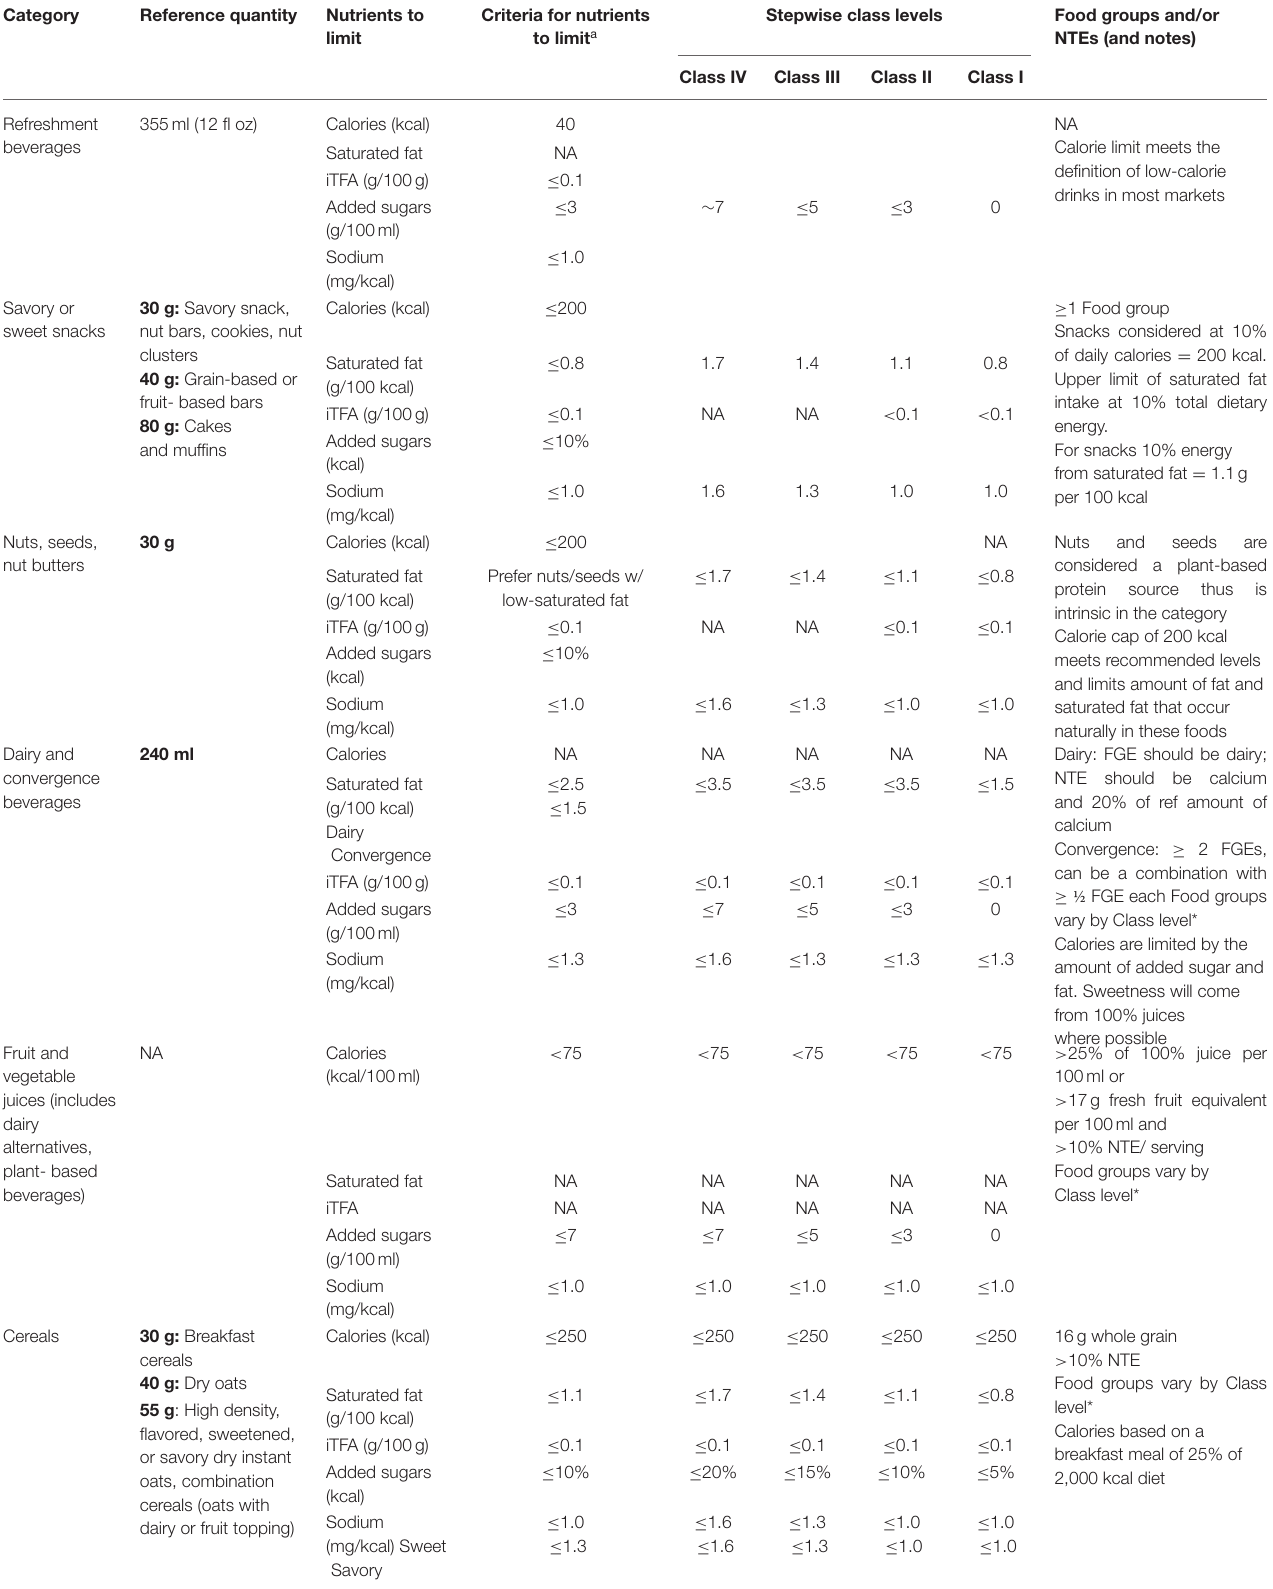
TABLE 5 | Specific nutrient requirements for all product categories according to PNC nutrient density classification.